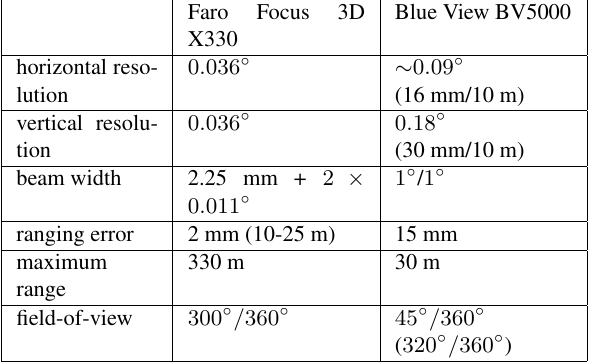
Table 1: TLS and MSS acquisition